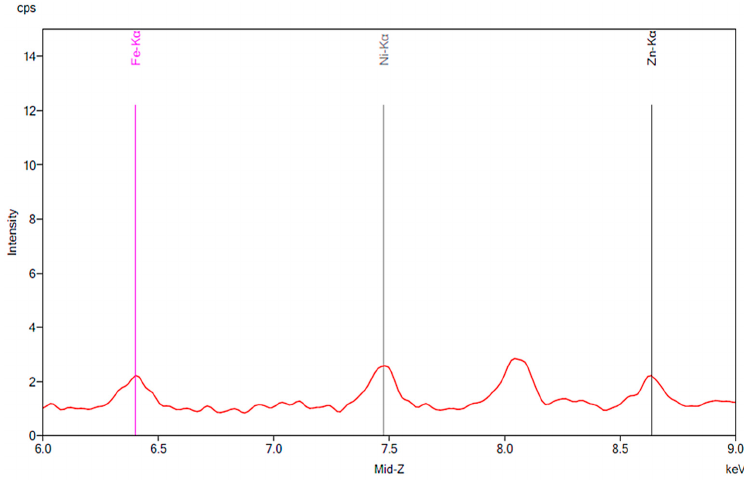
Figure 5. Baseline spectrum for a sample of cola. Similar units and scales are used for this figure as those shown in Figure 1.